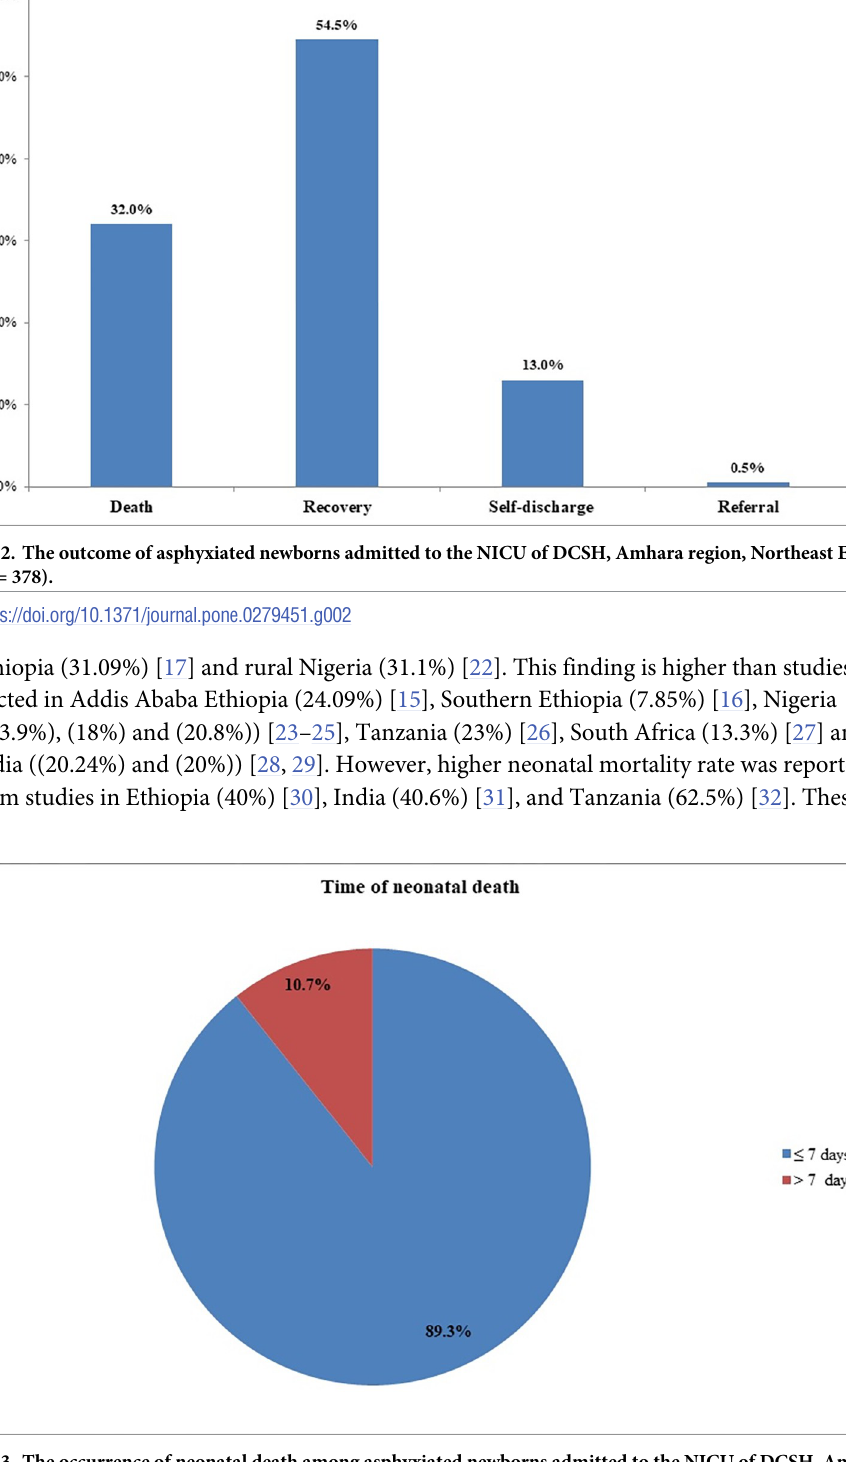
PLOS ONE | https://doi.org/10.1371/journal.pone.0279451 December21,